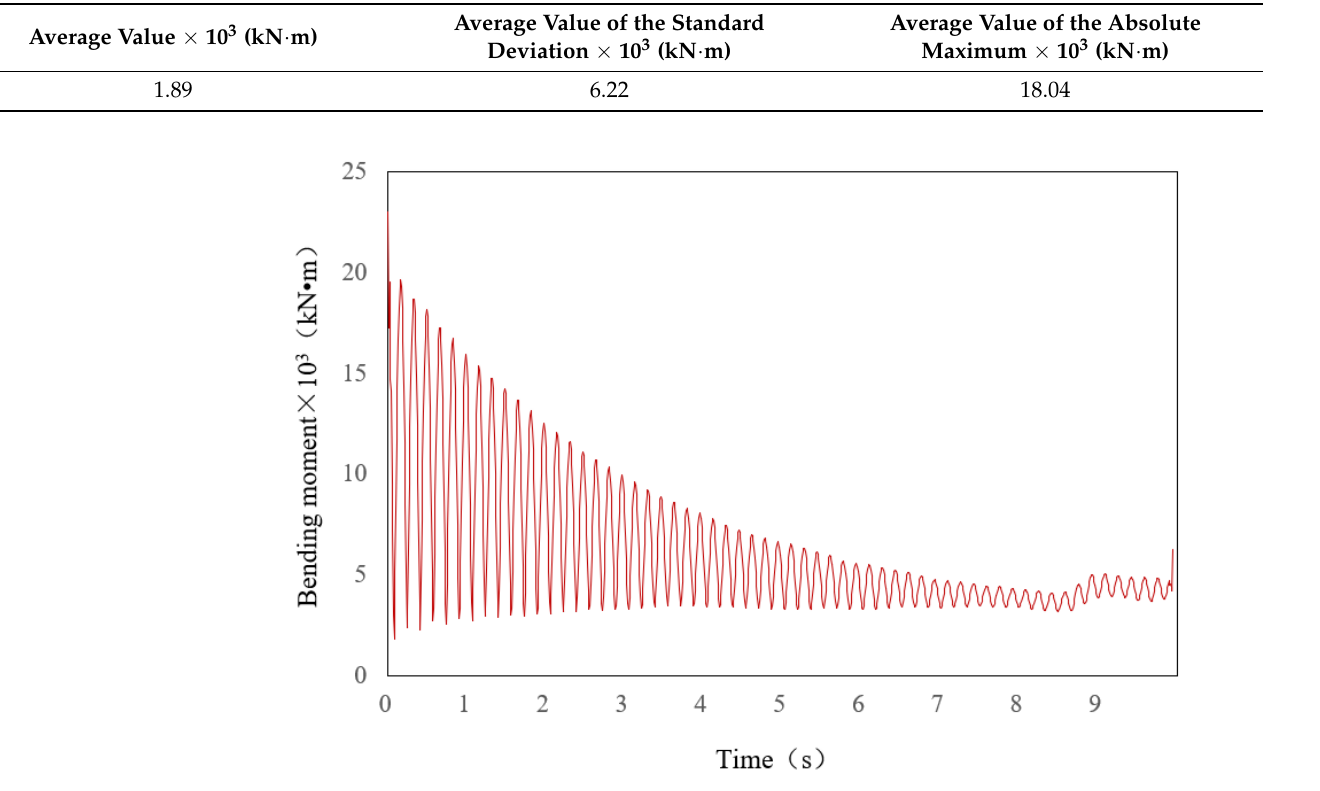
Figure 11. Standard deviation of the bending moment at the bottom section of P 2.